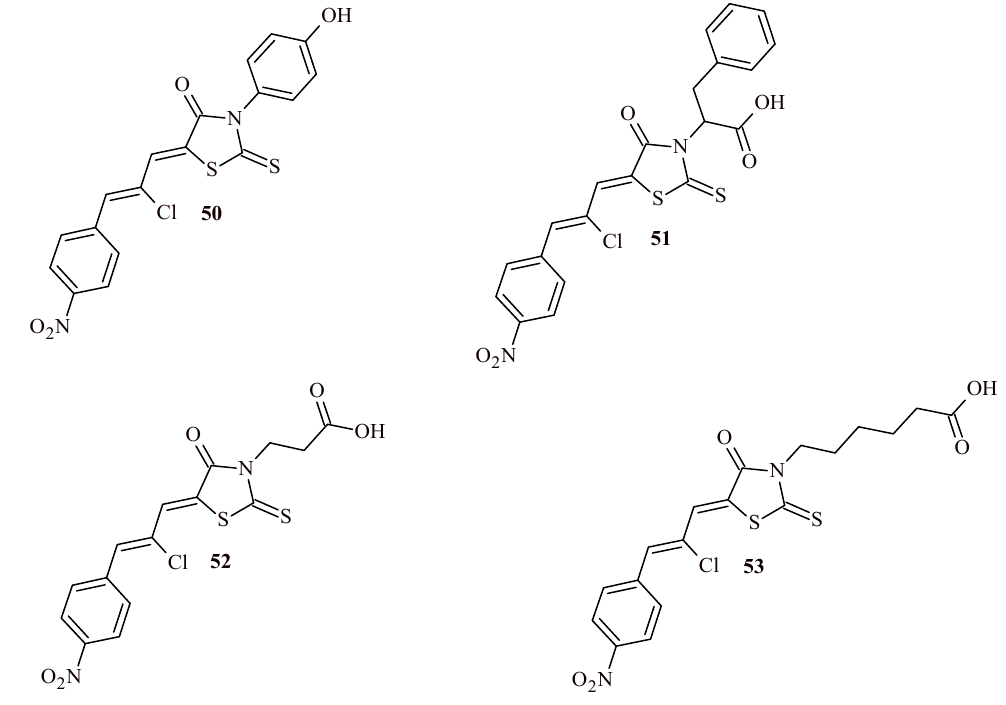
Figure 22. The ciminalum-rhodanine hybrids with anticancer properties.